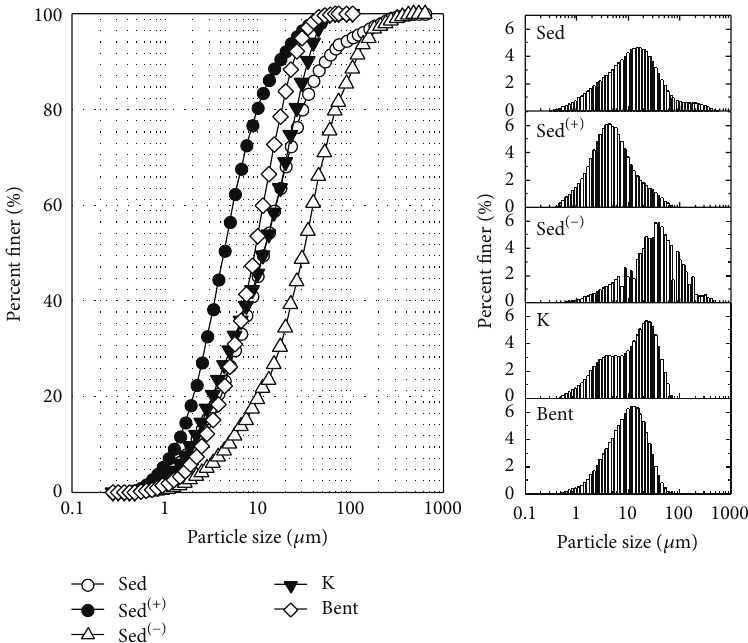
Figure 1: Particle size distribution curve of slurries.